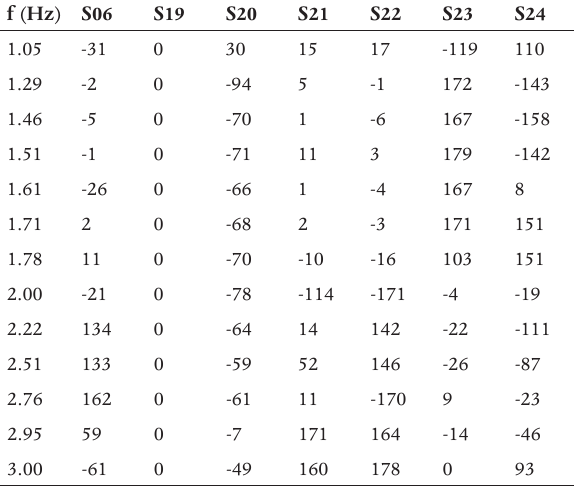
Table 6. Phase factor (°) in C3 with reference to S19.